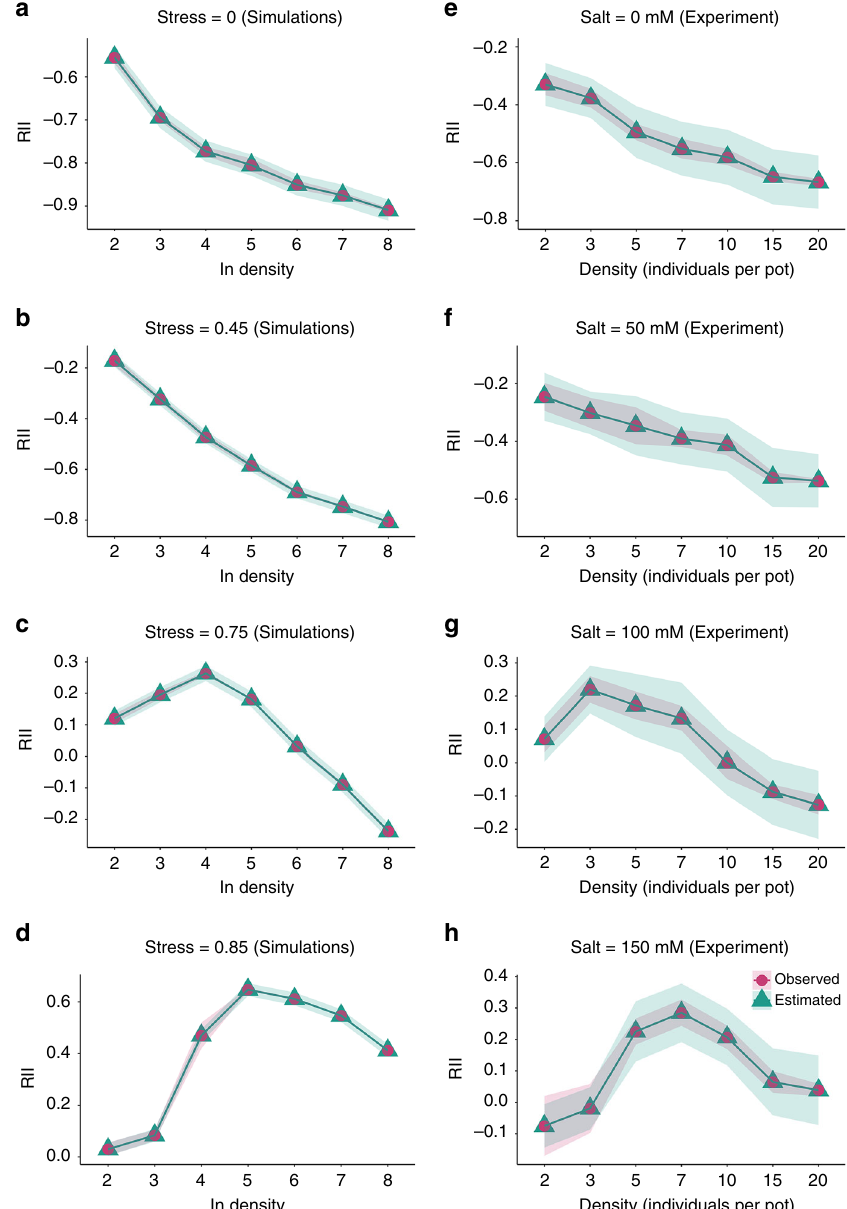
Fig. 4 Bayesian estimates and observed plant – plant interactions. a – d Bayesian estimates (with 95% credible set) and observed average index (RII; with 95% con fi dence interval) along a density gradient at each stress level in the simulations ( n = 5 independent samples in model simulations for the density gradient from two to eight at each stress level). e – h experimental data (for the density gradient from 2 to 20 plants per pot, n salt_0 = 25, 29, 17, 16, 15, 15 and 16 independent pots, respectively; n salt_50 = 20, 25, 13, 17, 16, 13, 16; n salt_100 = 30, 26, 15, 12, 14, 14, 13; n salt_150 = 29, 30, 15, 16, 17, 12, 11). Circles and represent observed values while triangles and lines represent Bayesian estimates. Source data are provided as a Source Data fi